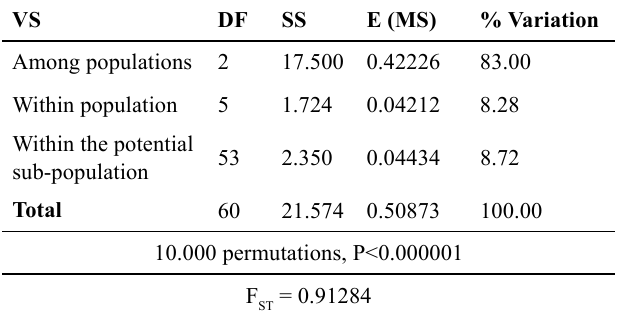
Table 1 . Analysis of Molecular Variance (AMOVA) applied to three hierarchical levels on data set before reallocation. VS : Variation Source; DF : degrees of freedom; SS : sum of squares; E (MS) : Estimate medium squares - variance components.